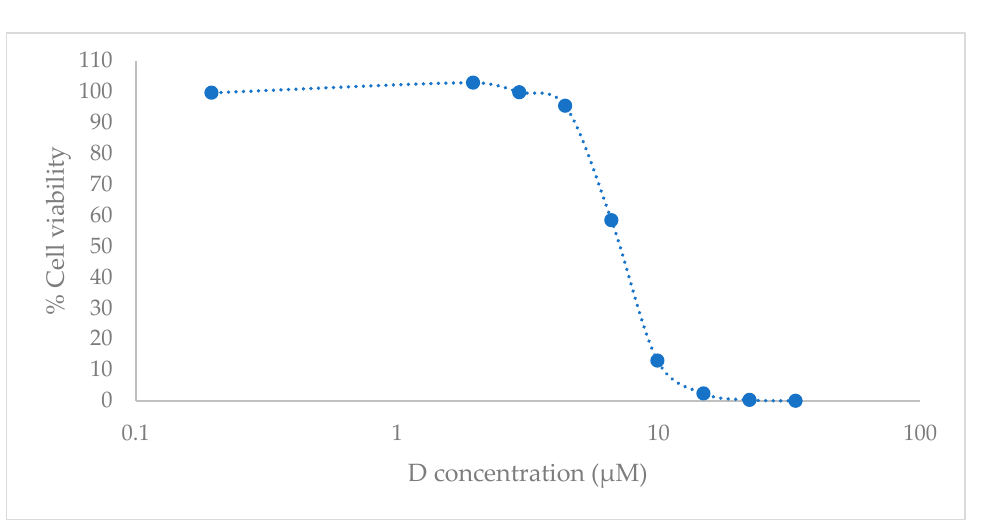
Figure 3. In vitro cell culture studies. HEK001 cell viability with luminometric assay after 72 h post treatment with D. Data are represented as the mean ( n = 3) of the cell viability percentage, referring to the untreated cell (negative control) and positive control with 1% of sodium dodecyl sulfate (SDS).